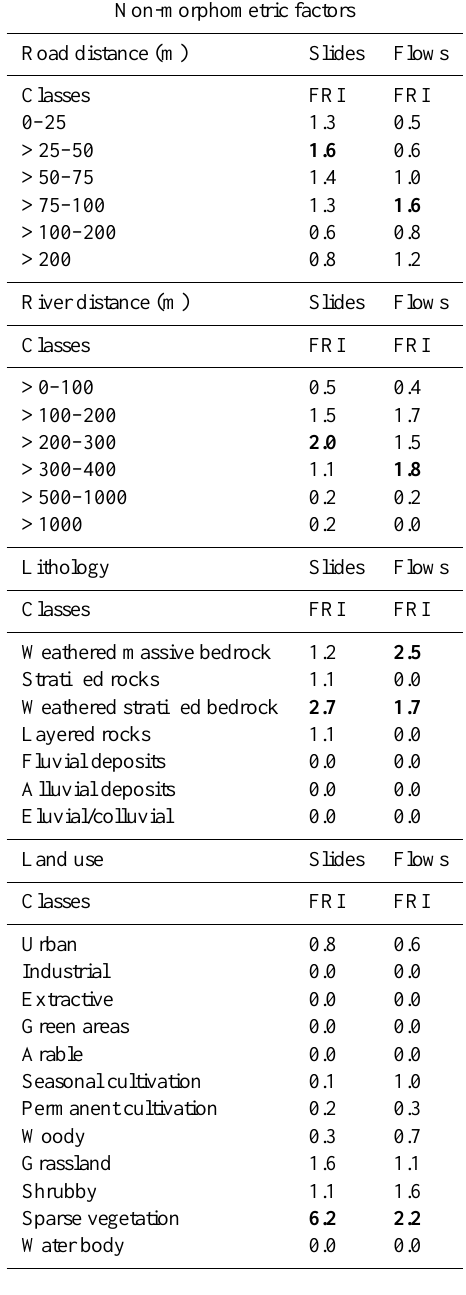
Table 3. Frequency ratio index (FRI) for each category of input factors. Values from medium to high susceptibility are shown in